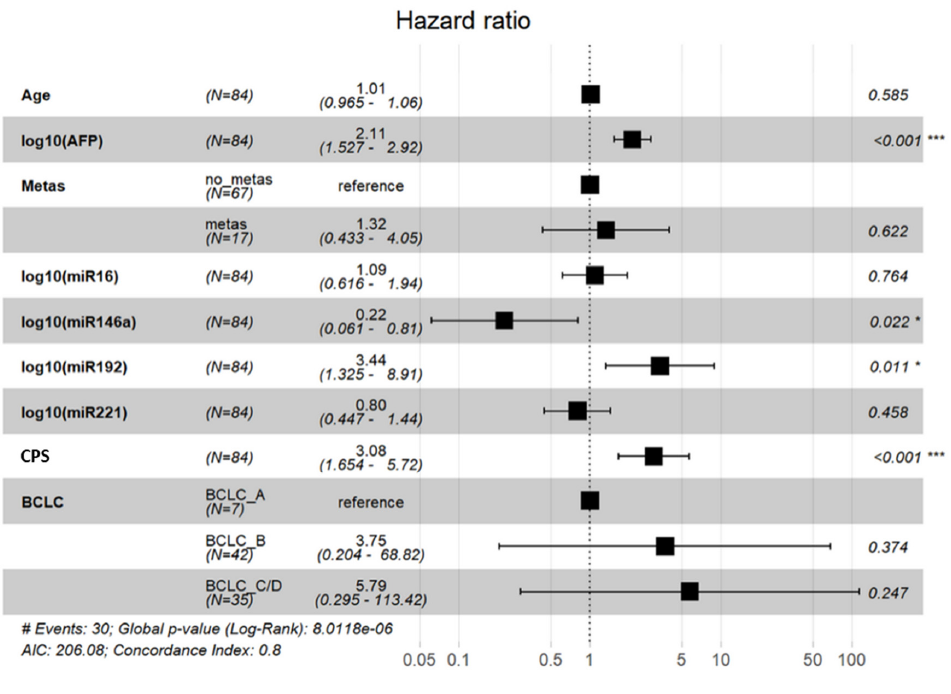
Figure 5. Cox regression model. Abbreviations: AFP, alpha-fetoprotein; Metas, presence of distant metastases; Child: child pugh score; BCLC: Barcelona Clinic for Liver Cancer. * p < 0.05; *** p < 0.001.